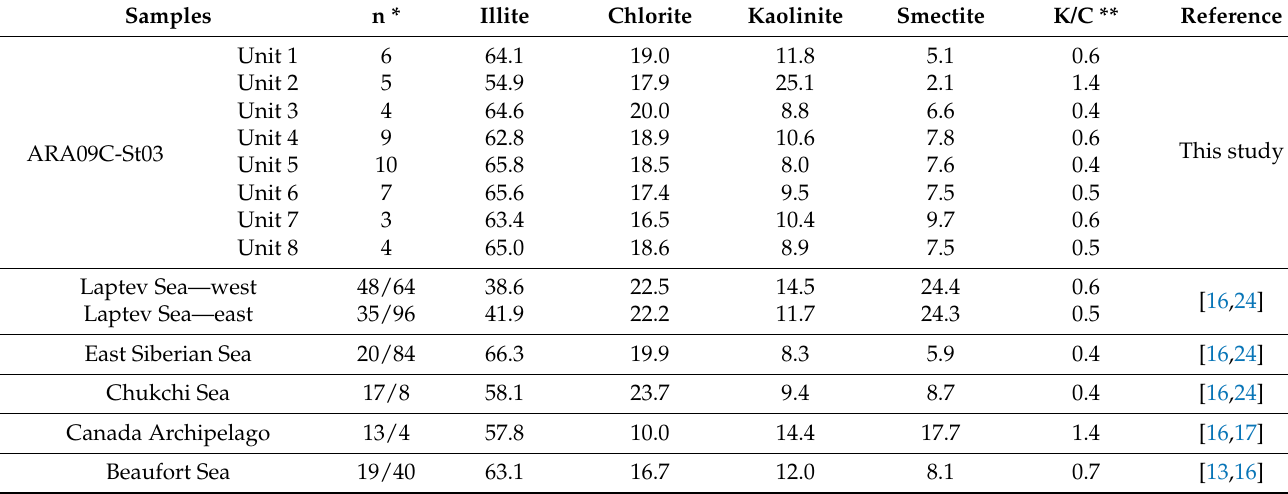
Table 2. Average relative compositions of clay minerals in core ARA09C-St03 and potential provenances. Samples